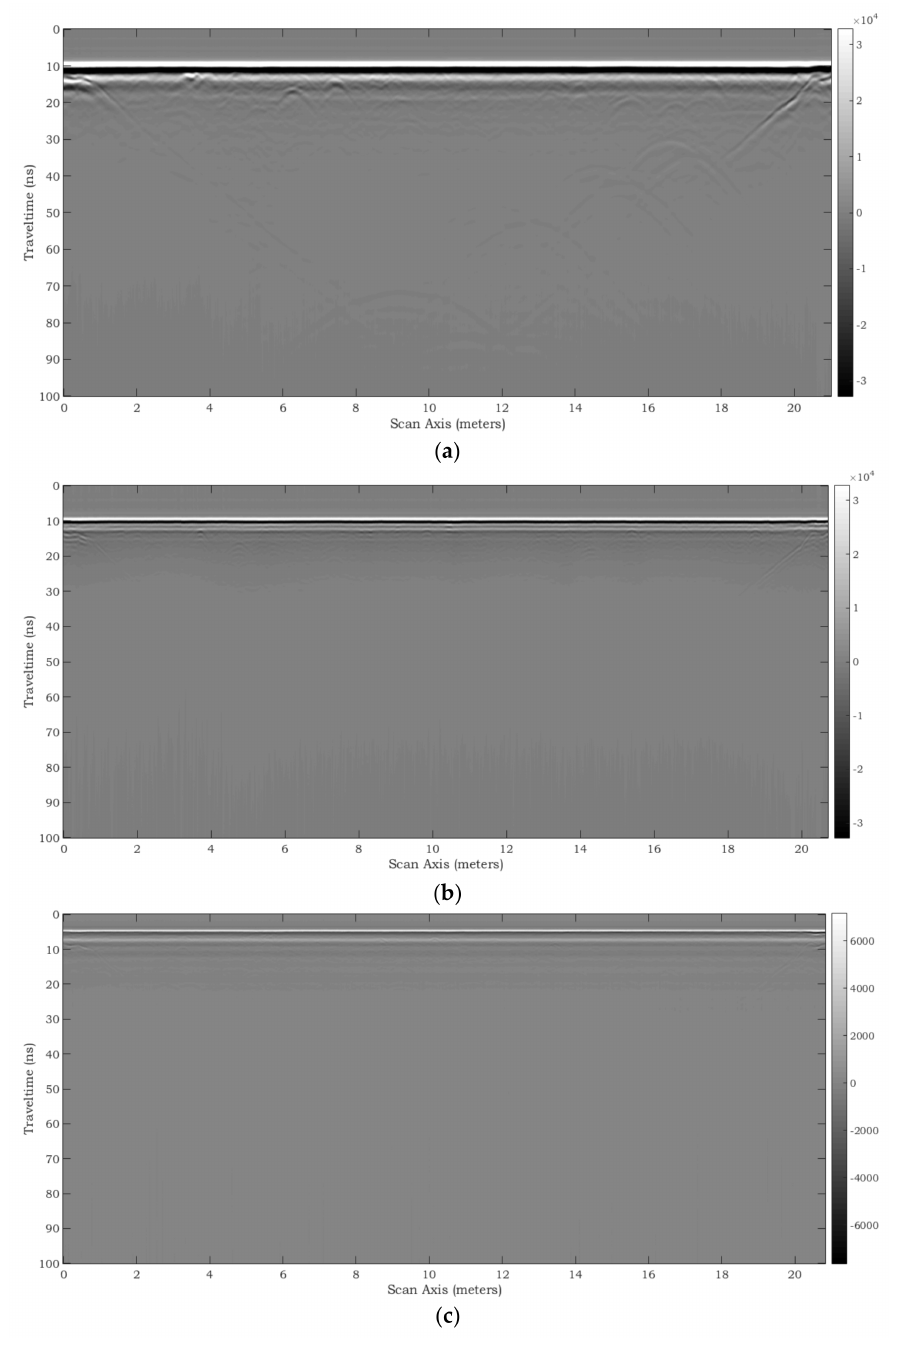
Figure 28. Profiles recorded in the limestone region by using GPR 3, on acquisition line 2, with antennas operating at: ( a ) 200 MHz; ( b ) 600 MHz; ( c ) 900